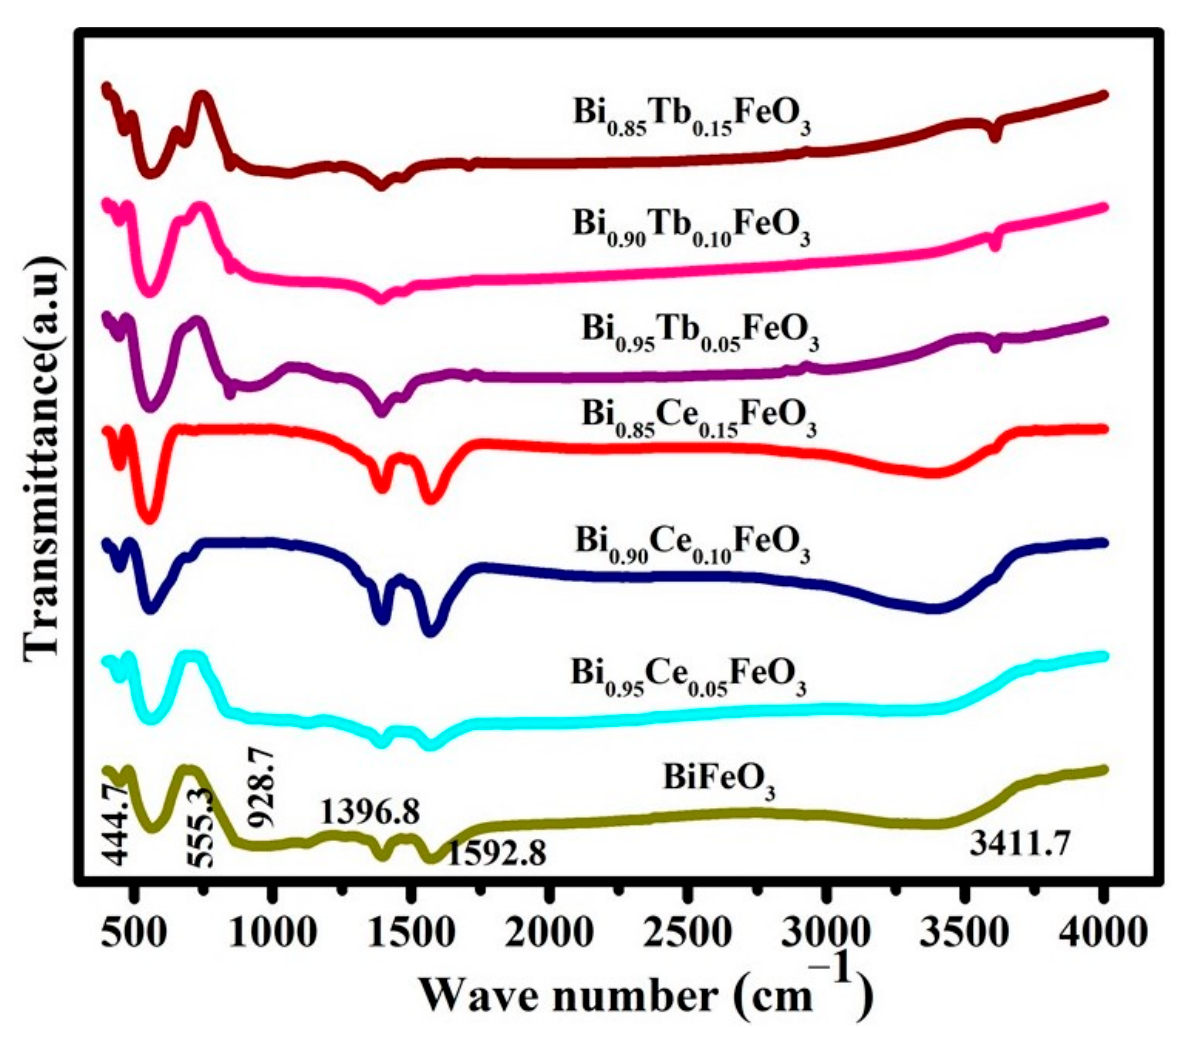
Figure 3. FT-IR spectrum of the as-prepared BFO: RE nanostructures. The UV–Vis diffuse reflectance spectra (DRS) of Bi 1 − x R x FeO 3 (R = Ce, Tb; x = 0.00, 0.05, 0.10 and 0.15) nanostructures are shown in Figure 4a,b and the band gaps deduced from Kubelka-Munk function [45]. The nanostructures exhibited a greater absorption in the visible range and the optical bandgap was found to be 2.03 eV [38] for BiFeO 3 nanostructures. The observed band-gap energies [1.95, 1.91 and 1.82 eV for Bi 1 − x Ce x FeO 3 (x = 0.05, 0.10 and 0.15)] are noticeably reduced with an increase of RE concentration. The obtained decreased bandgaps were found to be 2.00, 1.90 and 1.87 eV for the Bi 1 − x Tb x FeO 3 (x = 0.05, 0.10 and 0.15) nanostructures,